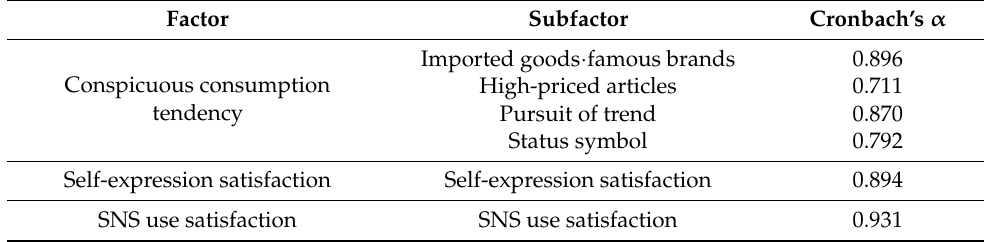
Table 4. Verification of reliability.